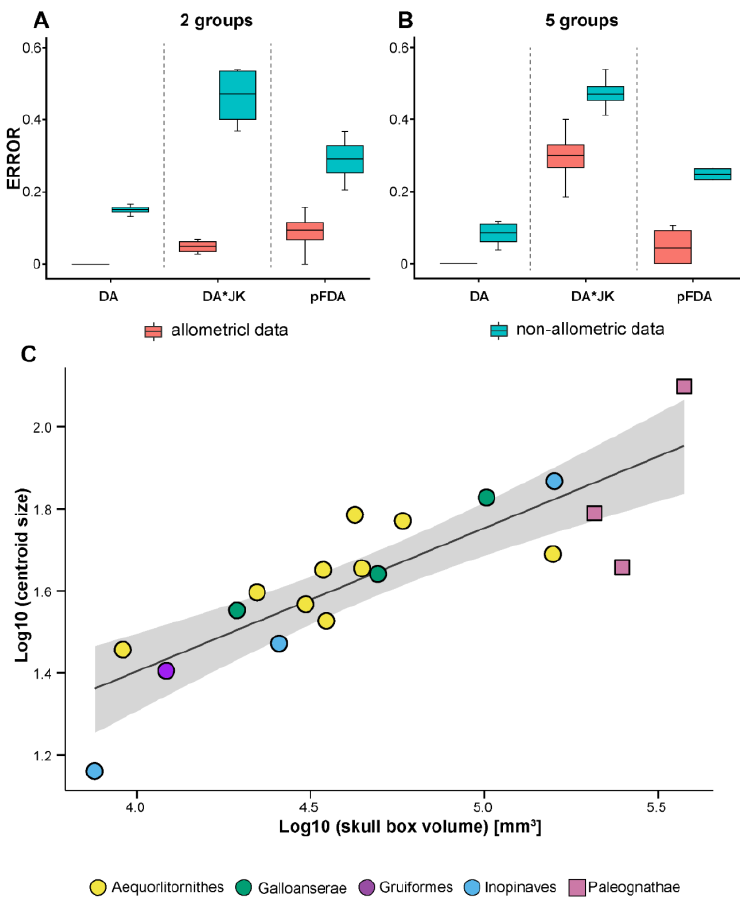
Figure 3. Errors of correct taxonomic identification for all comparisons of Dataset A-D. (A) Two-group identification (Palaeognathae and Neognathae) before (red) and after (green) correction for allometry. DA, Discriminant analysis; DA*JK, Discriminant Analysis with jackknife resampling; pFDA, phylogenetic Flexible Discriminant Analysis. (B) Five-group identification (Palaeognathae, Aequorlitornithes, Galloanserae, Gruiformes and Inopinaves). (C) OLS regression (black line) between log-transformed skull box volume and log-transformed centroid size of the vomer. Grey shadow marks the area of the 95% confidence